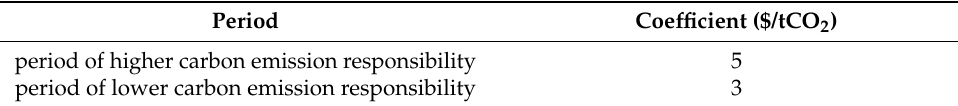
Table 4. Coefficients of the Carbon Incentive Mechanism.